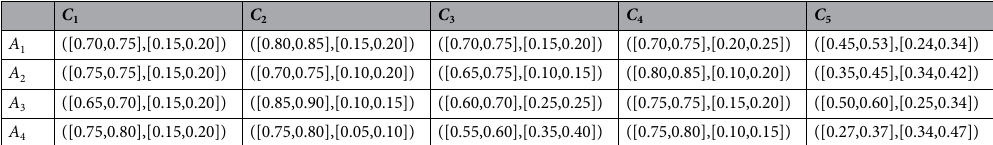
Table 2. Interval-valued intuitionistic fuzzy matrix given by decision-maker E 2 .